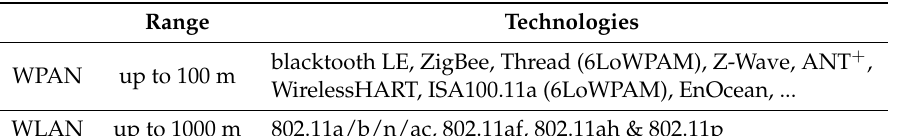
Table 2. WPAN and WLAN connectivity technologies.